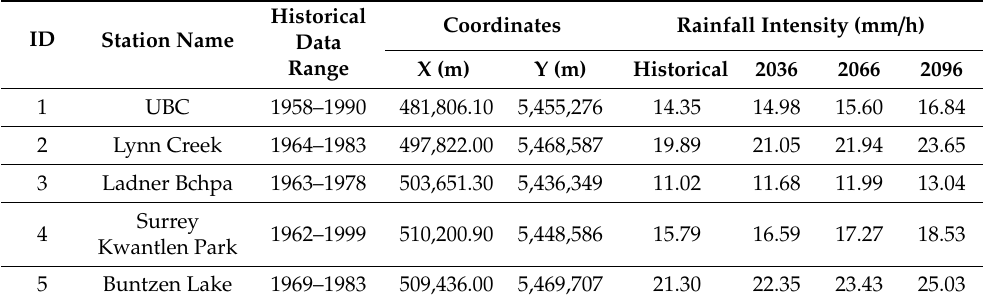
Table 3. Projected rainfall intensity for Vancouver for Scenarios 2036, 2066, and 2096 [51,56], 60 min duration, and 10-year RP. The coordinates are in